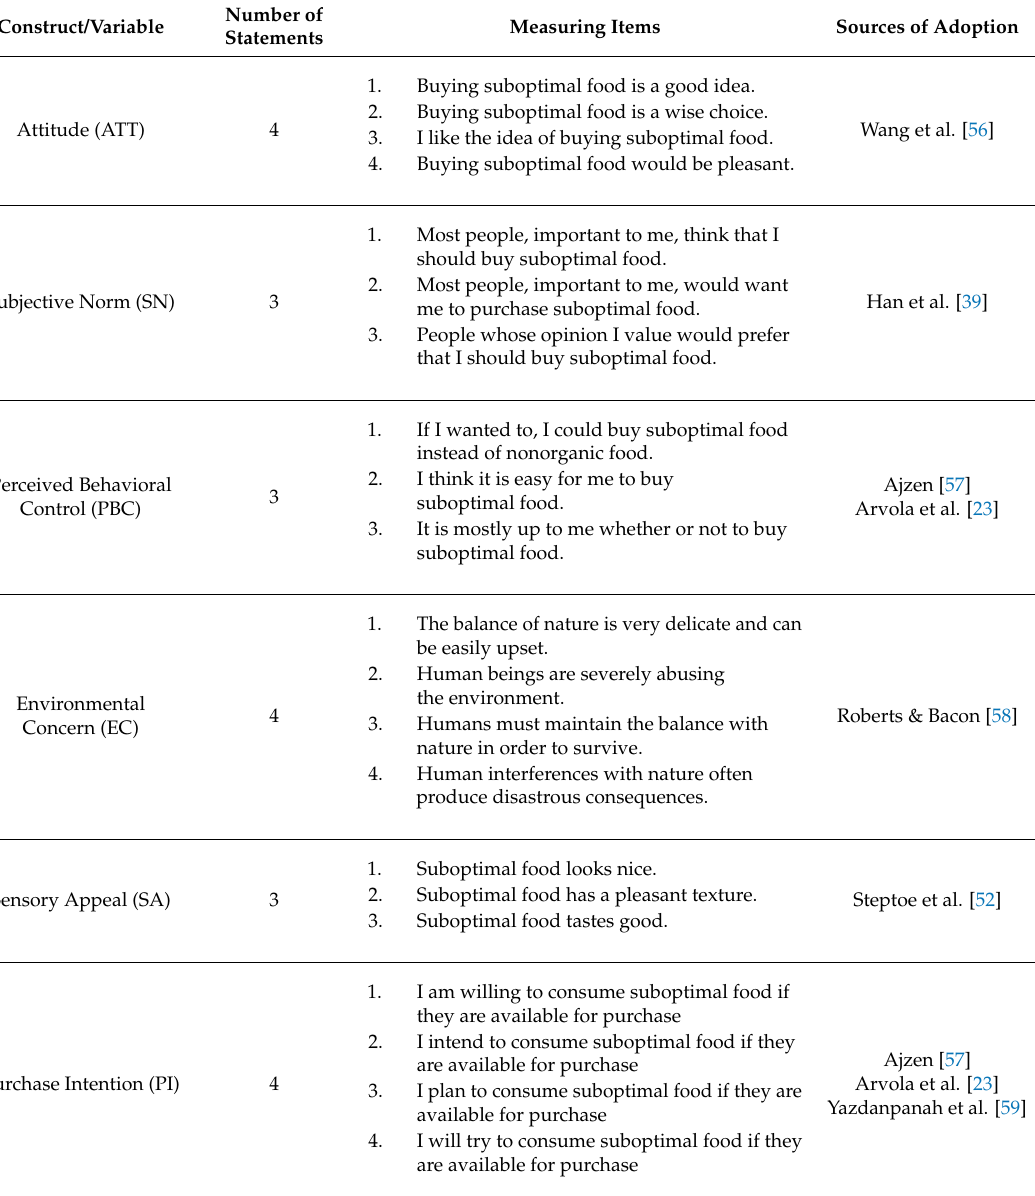
Table 1. Constructs/variables and corresponding measuring statements included in the